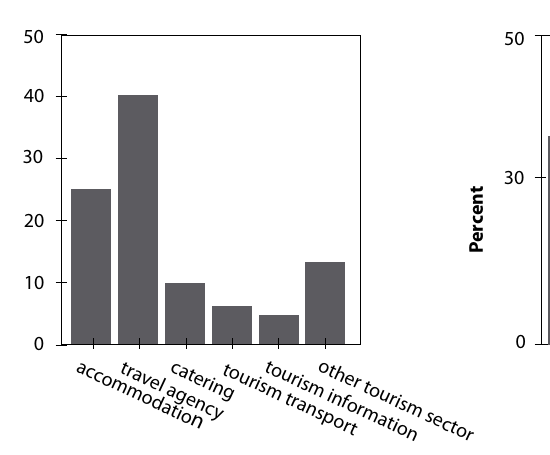
Fig. 3. Variation of the age of the surveyed Latvian tourism enterprises,